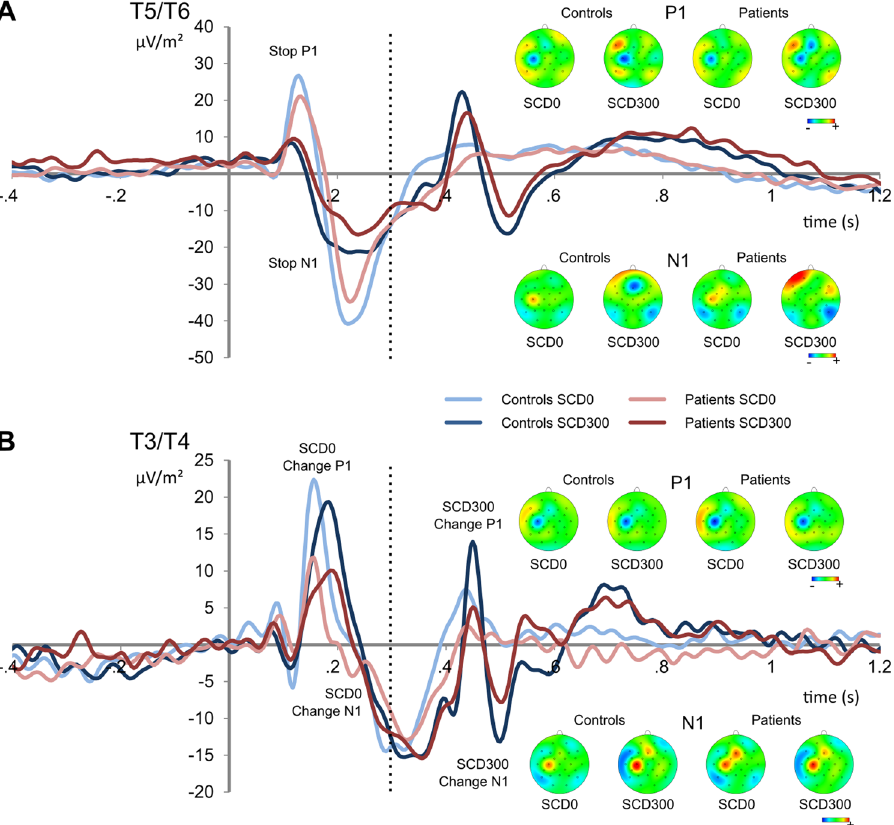
Figure 3. Event-related potential (ERP) components showing the P1 and N1 following the visual STOP stimuli (part A) and following the auditory CHANGE stimuli (part B). Time point zero denotes the time point of STOP stimulus delivery. Blue colors denote the control group, red colors the Tourette patient group. Lighter colors show the stop-change delay (SCD)-0 conditions, darker colors the SCD-300 condition. The scalp topography plots show the maximum amplitude of the P1 and N1 for controls and Tourette patients. Red colors show positivity, blue colors show negativity. The dashed vertical lines denote the time point of CHANGE stimulus delivery in the SCD-300